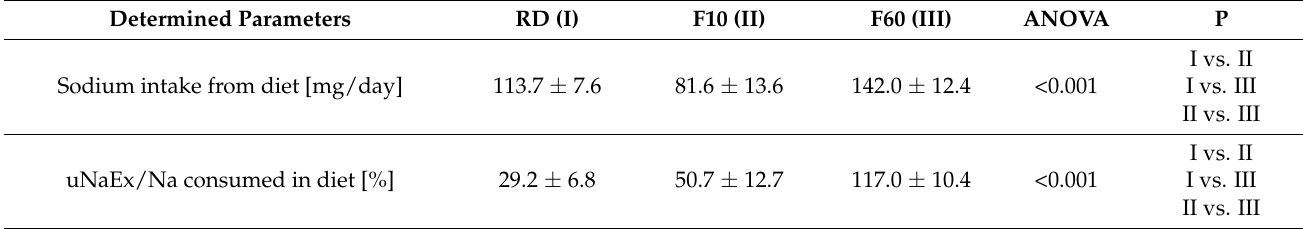
Table 3. The mean daily amount of Sodium, Calcium and Phosphate provided in RD, F10 and F60 diet and the ratio of daily urinary Excretion of Sodium, Calcium and Phosphate as percentage of their daily dietary intake from